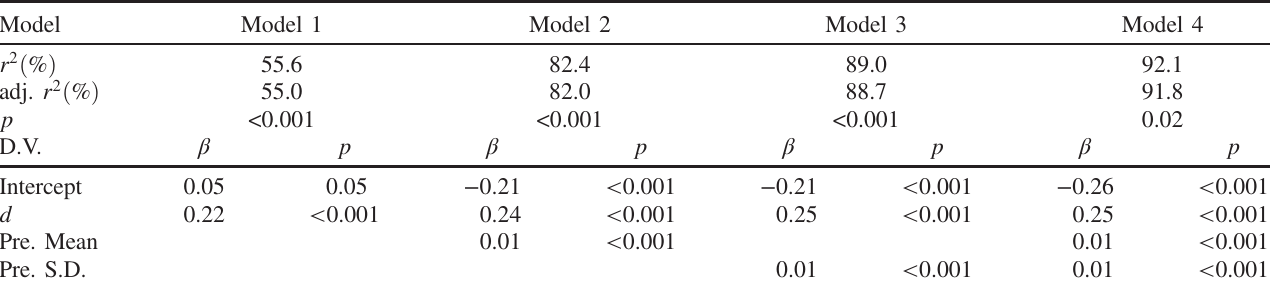
TABLE IV. MLR exploring relationships between g and dependent variables (D.V.) for d , pretest mean (Pre. Mean), and pretest standard deviation (Pre. S.D.).